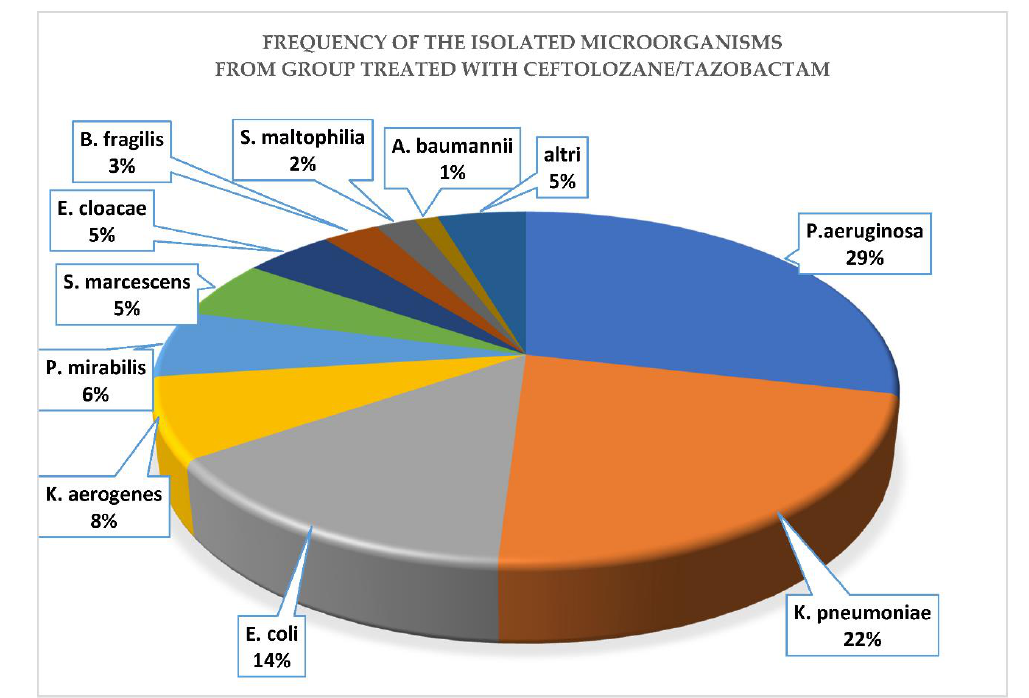
Figure A1. Frequency of the isolated microorganisms from group treated with ceftolozane/tazobactam.